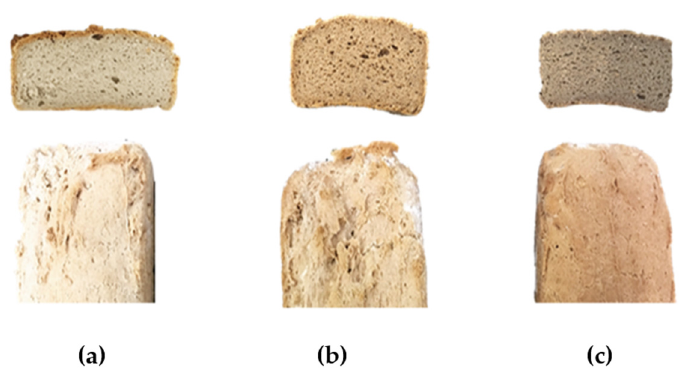
Figure 1. Gluten-free breads without acorn flour. Control ( a ), with A23% ( b ) and A35% ( c ) acorn flour.